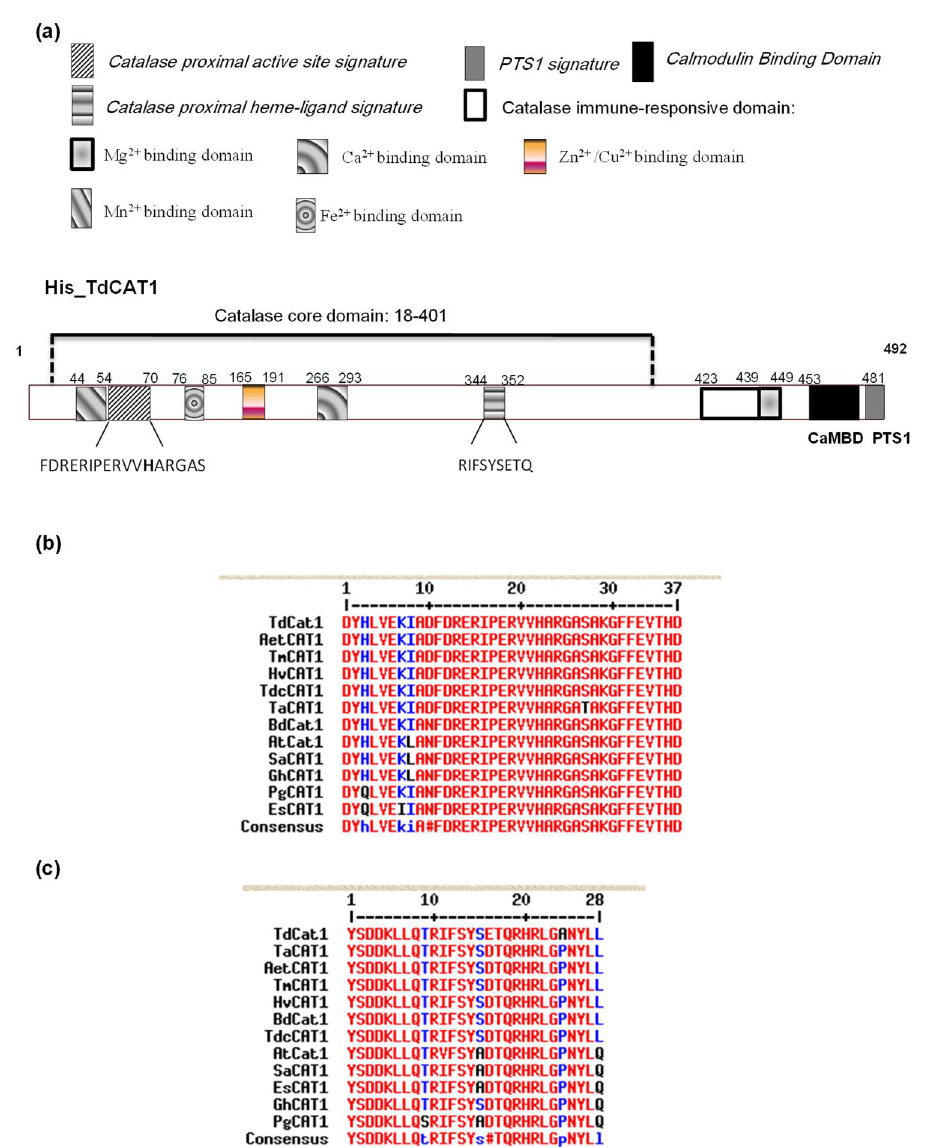
Figure 1. Schematic representation of TdCAT1 protein structure and alignment of the